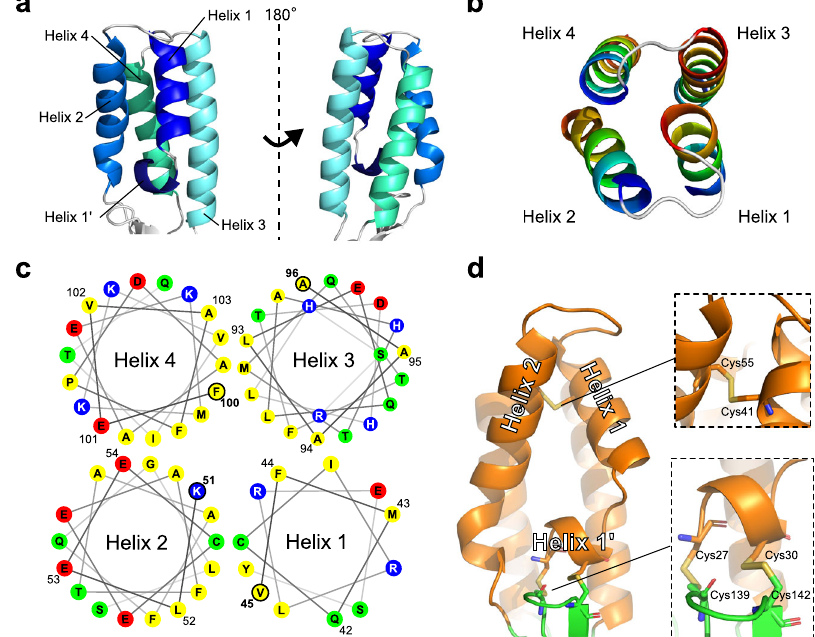
Fig. 2 N-terminal 4HB domain of SPACA6. a Ribbon diagram of the N-terminal 4HB. b Top-down view of four-helix bundle, with each helix colored dark blue at N terminus and dark red at C terminus. c Top-down helical wheel diagram of the 4HB with each residue presented as a circle marked with the one- letter amino-acid code; only the four amino acids that lie on the top of the wheel are numbered. Non-polar residues are colored yellow, polar non-charged residues are green, positively charged residues are blue, and negatively charged residues are red. d Triangular face of the 4HB domain with the 4HB colored orange and hinge colored green. The two insets display the disul fi de bonds as